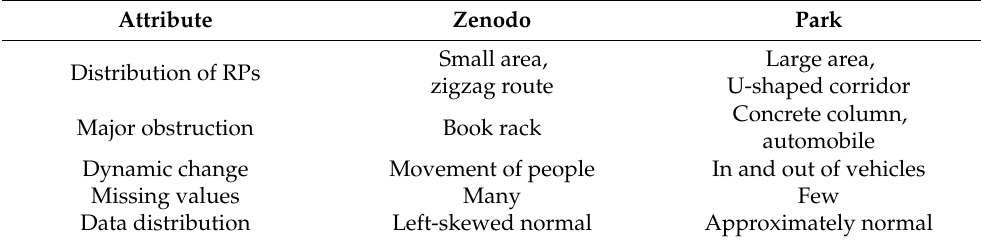
Table 1 compares the Zenodo and Park datasets. Table 1. Comparison of Zenodo and park